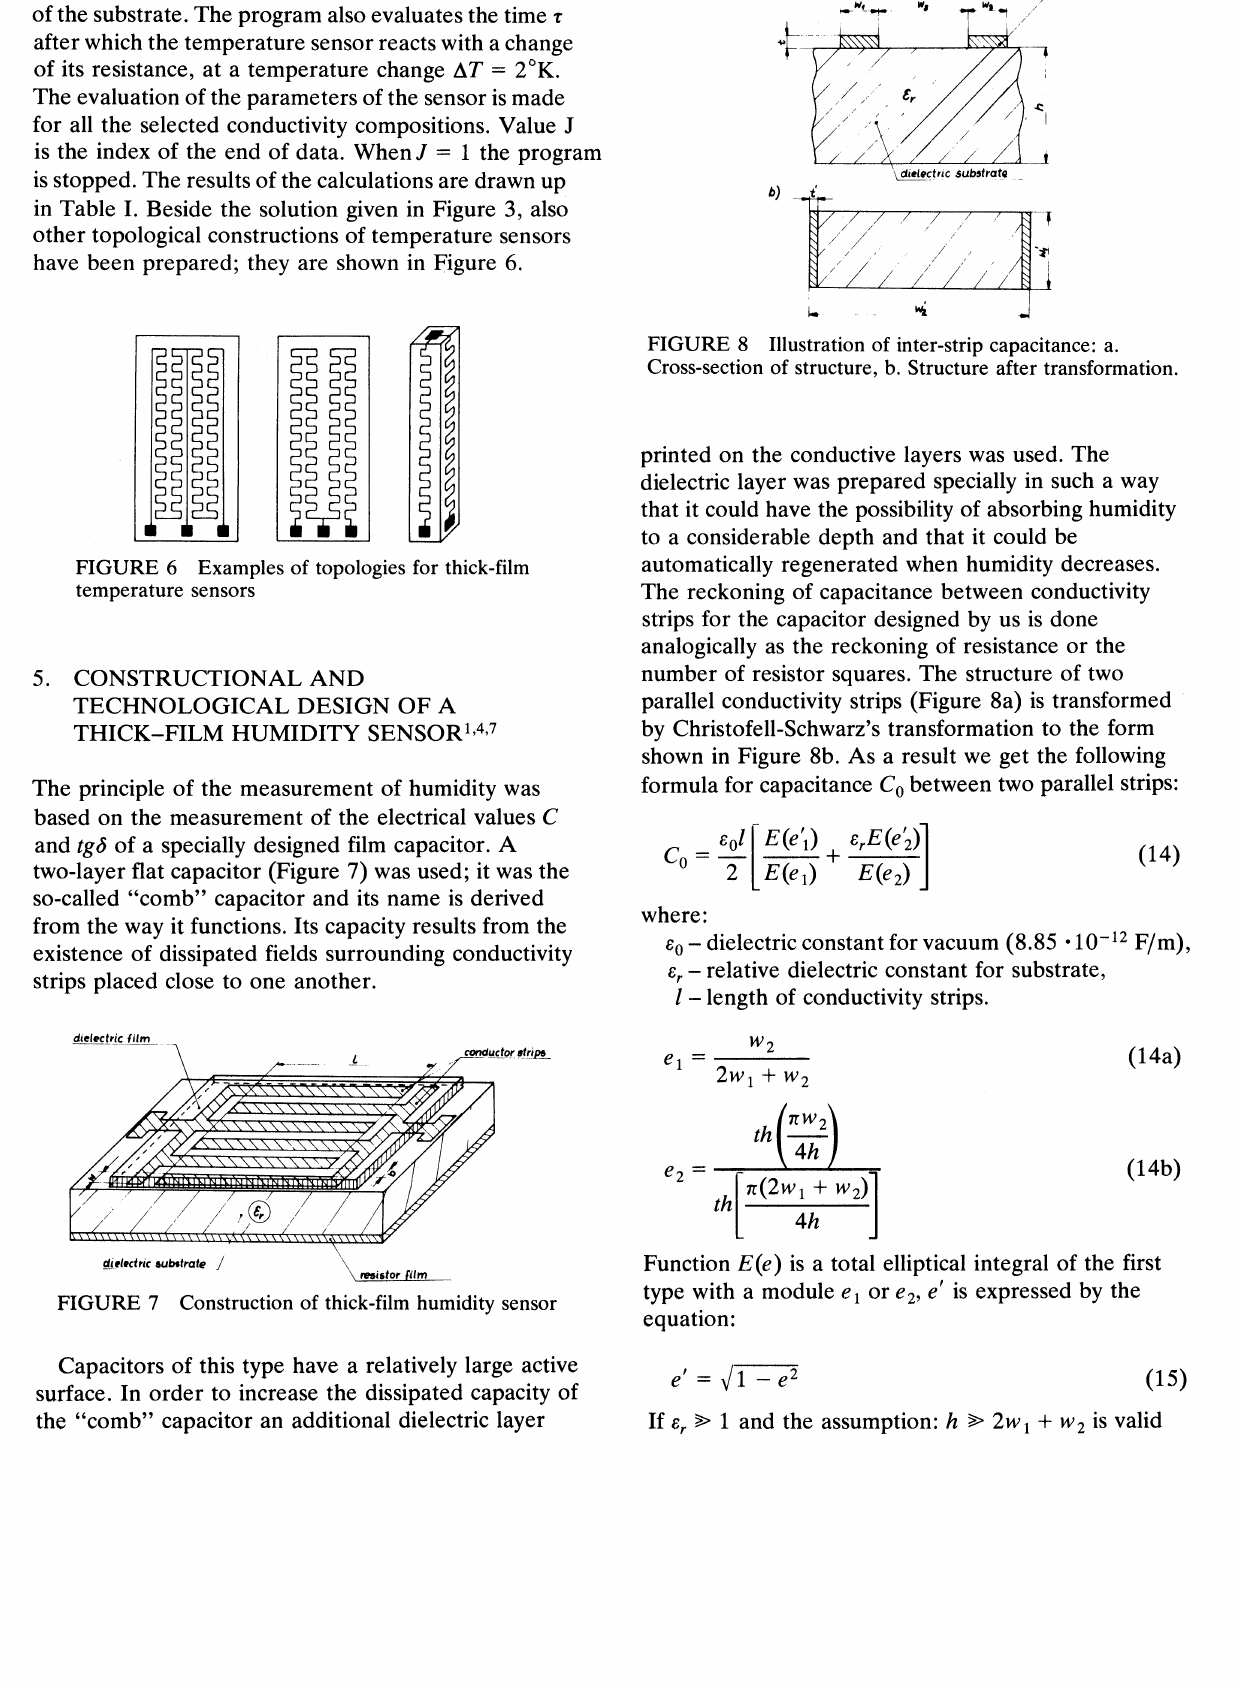
FIGURE 8 Illustration of inter-strip capacitance: a. Cross-section of structure, b. Structure after transformation.